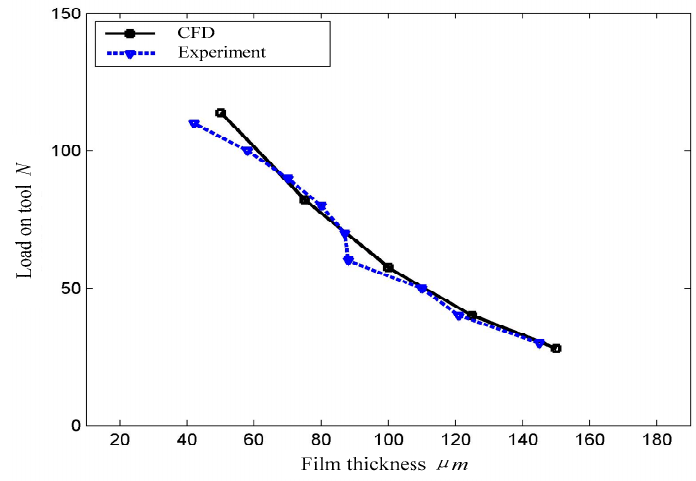
Figure 8. Film thickness experiment and prediction.